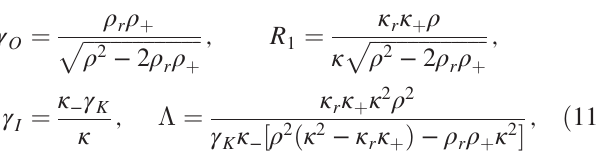
ffiffiffiffiffiffiffiffiffiffiffiffi p 1 þ Λ